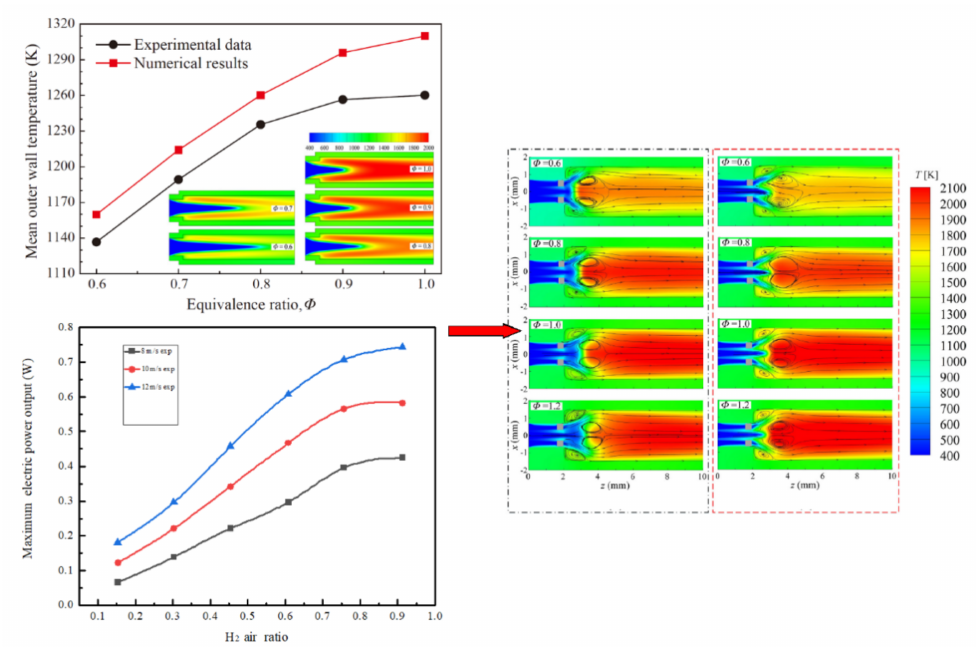
Figure 4. Combustion of the micro-combustor at different fuel flow rates when the H 2 /air ratio is